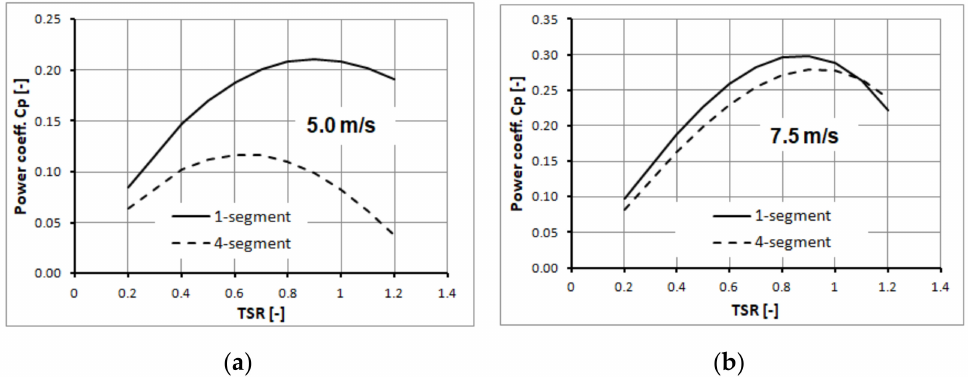
Figure 14. Comparison of rotor effectiveness (Cp) at different TSR; ( a ) characteristics at 5.0 m/s; ( b ) characteristics at 7.5